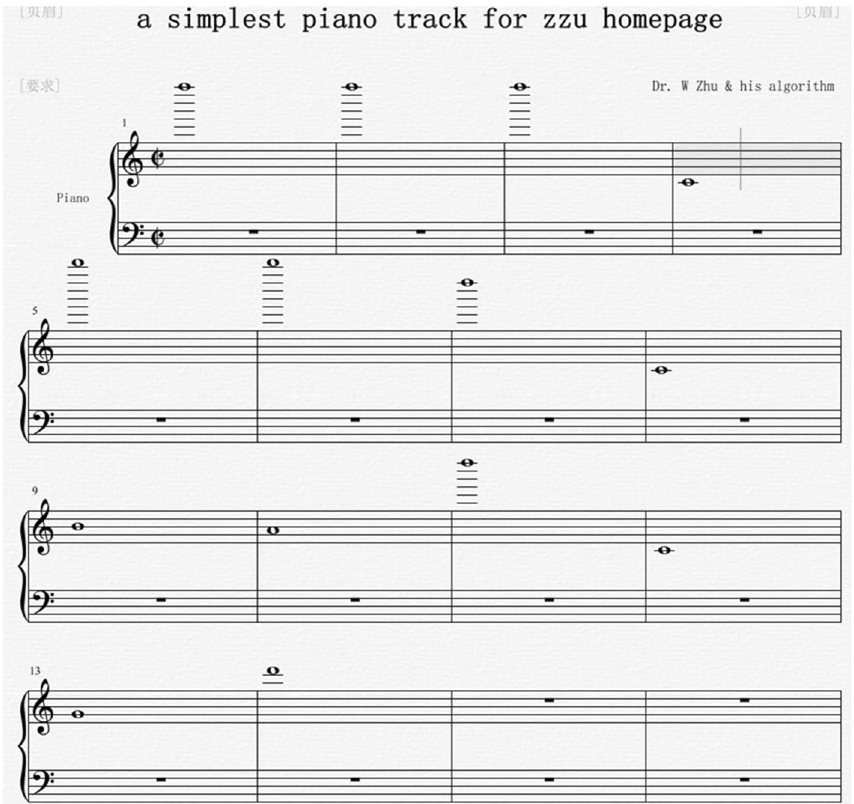
Figure 3. An example on AAQRC generation: step 2: music score of